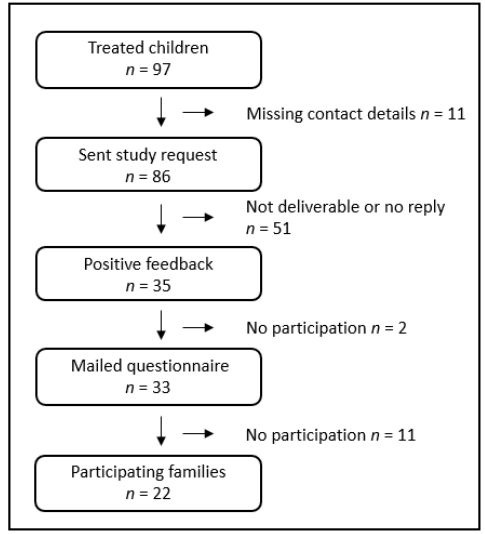
Figure 2. Recruitment of study participants.